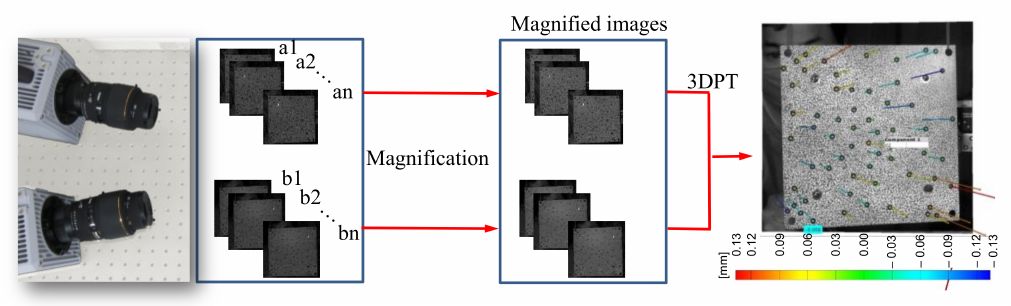
Figure 7. Procedure for capturing a series of images and magnifying captured images using the 3DPT method.